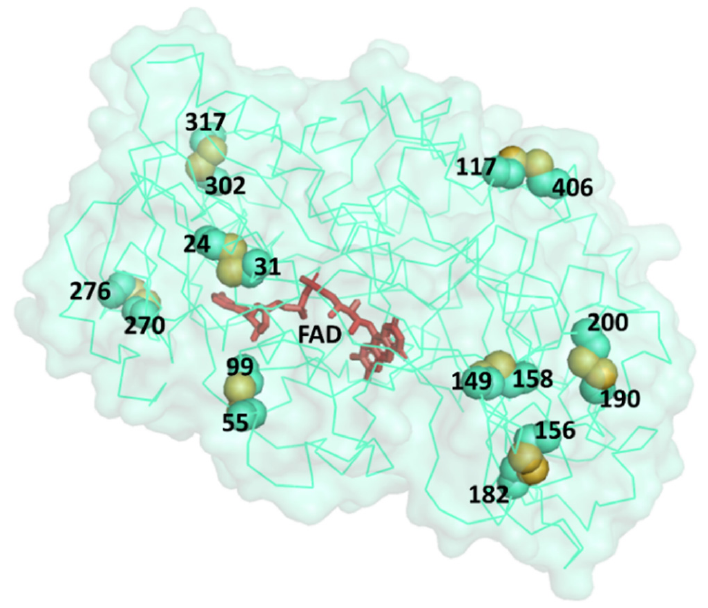
Figure 1. Conceptual illustration of the pipeline to realize rational bioengineering designs of GOx for optimizing protein stability.